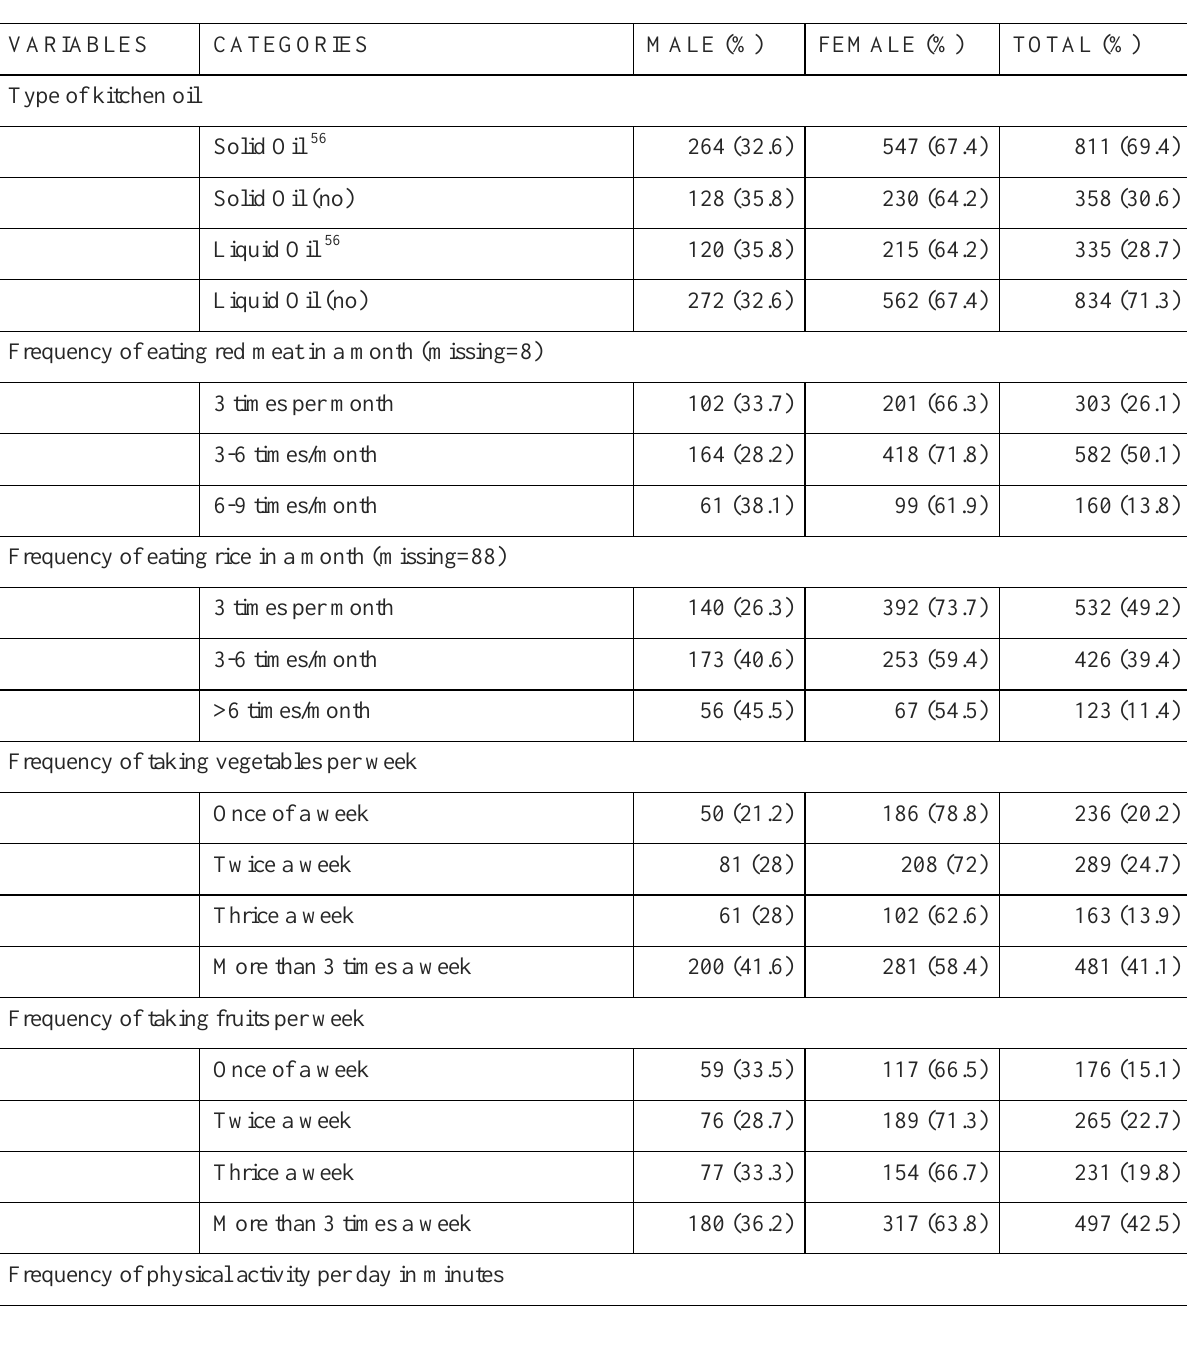
Table 2: Frequency distribution of the Behavior factors evaluated (n=1,169).